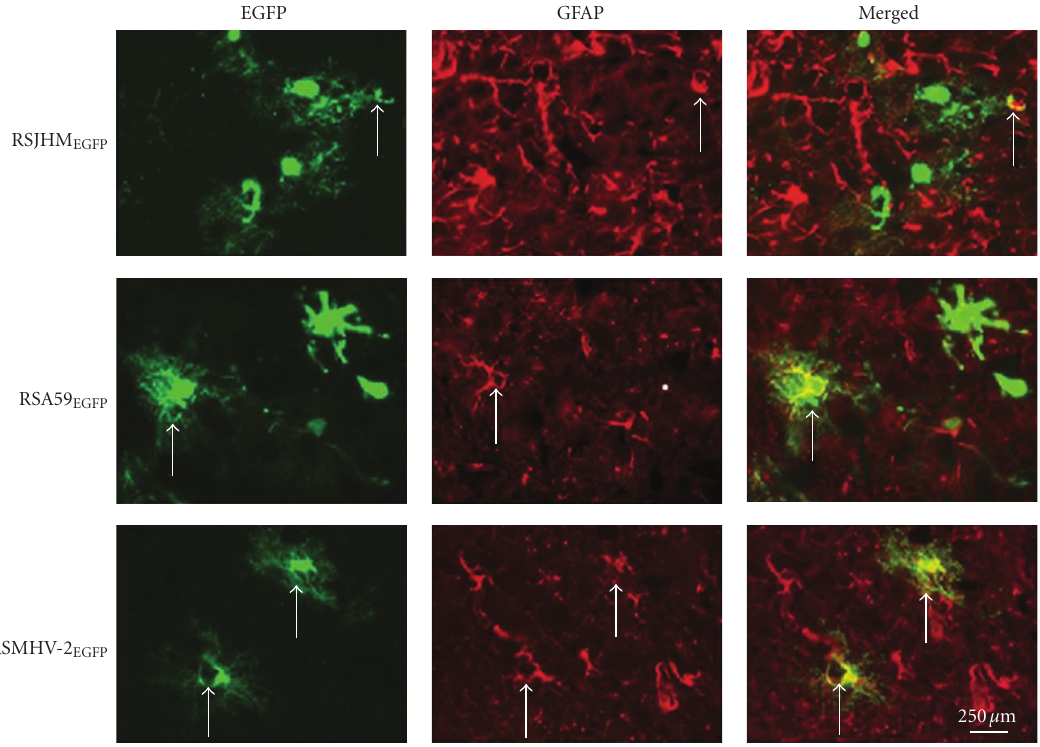
Figure 19: Colocalization of EGFP positive cells with astrocyte marker at day 5 post-infection. Mice were infected intracranially with RSJHM EGFP , RSA59 EGFP and RSMHV2 EGFP . Infected mice were sacrificed at day 5 post-infection; brains were processed, sectioned and then immune labeled with anti GFAP (astrocytic marker) antiserum, then stained with Texas red goat anti-mouse IgG as secondary antibodies. EGFP fluorescence was used to detect viral antigen positive cells; red fluorescence was used to detect GFAP in astrocytes. Merged images show colocalization of GFAP and EGFP positive cells. Arrows identify cells double positive for viral antigen and GFAP. Bar = 250 microns. (Adapted from Das [116]